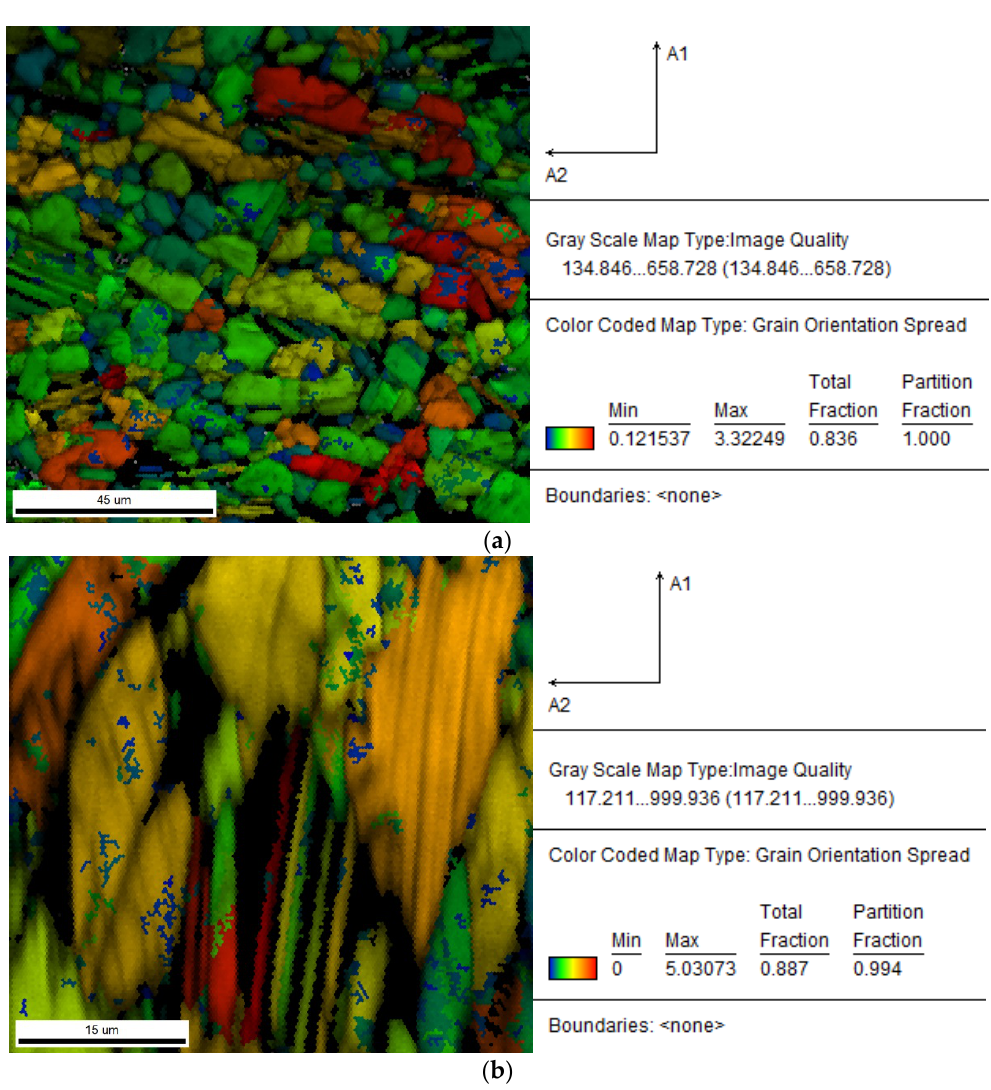
Figure 11. The grain orientation spread (GOS) maps of different positions of the forged blade: ( a ) center position; ( b ) edge position.